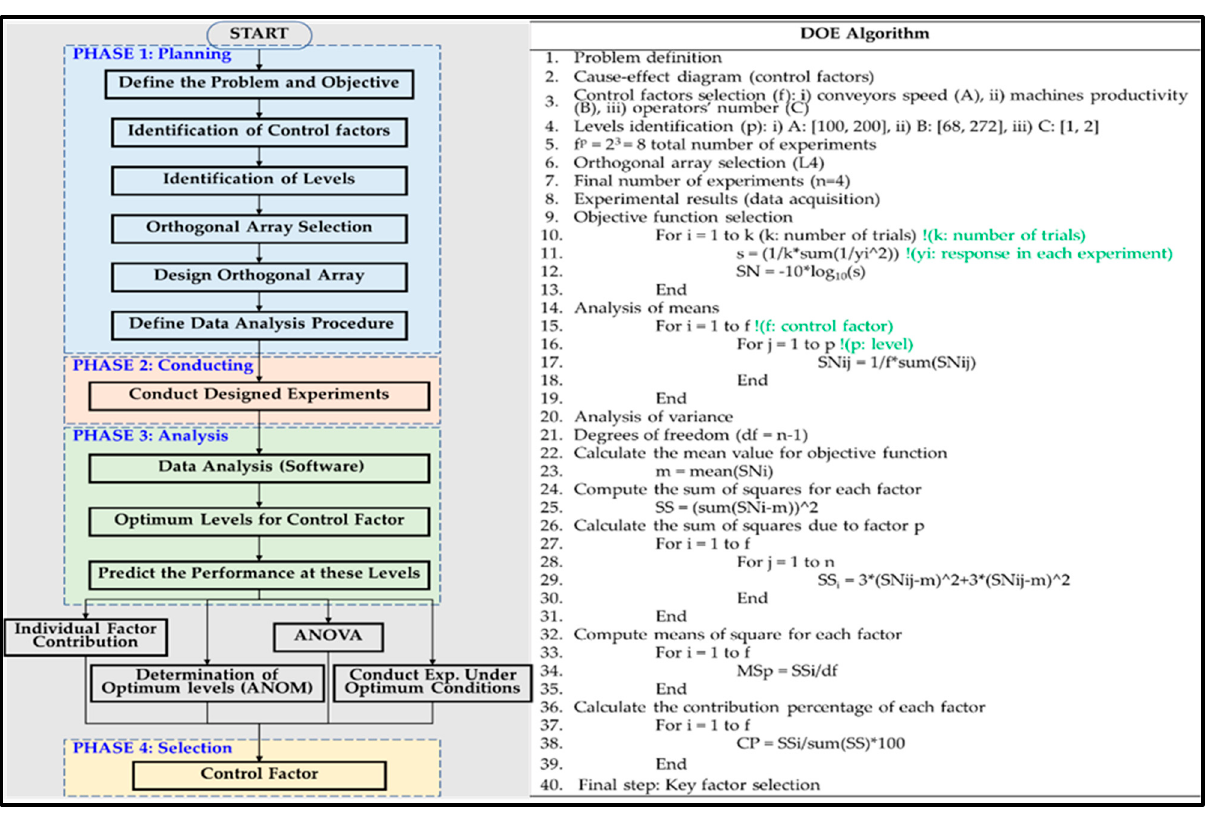
Figure 7. ( left ) DOE fl owchart; ( right ) DOE pseudocode.